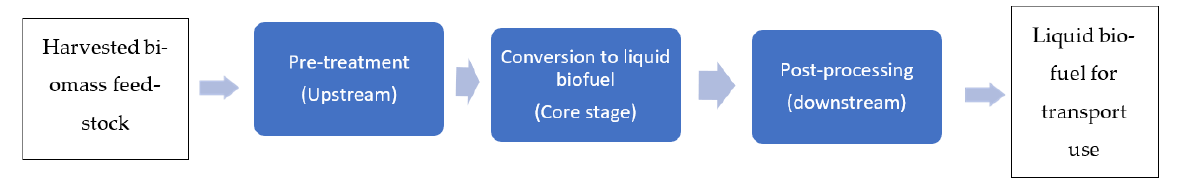
Figure 1. Basic structure of a generalized biofuel production value chain.